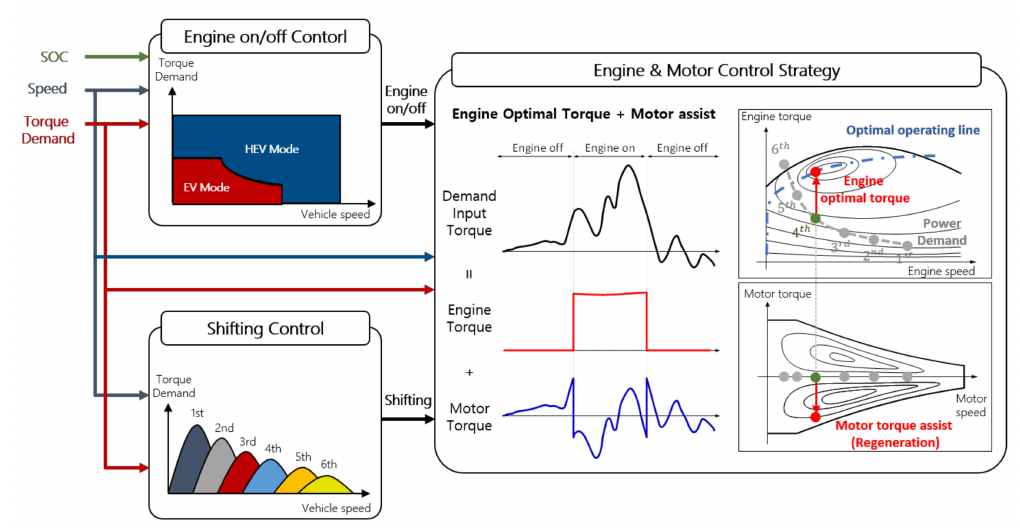
Figure 19. Control Strategies of the Ioniq